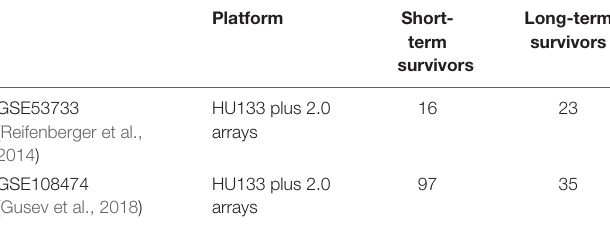
TABLE 5 | Statistics of datasets under study.